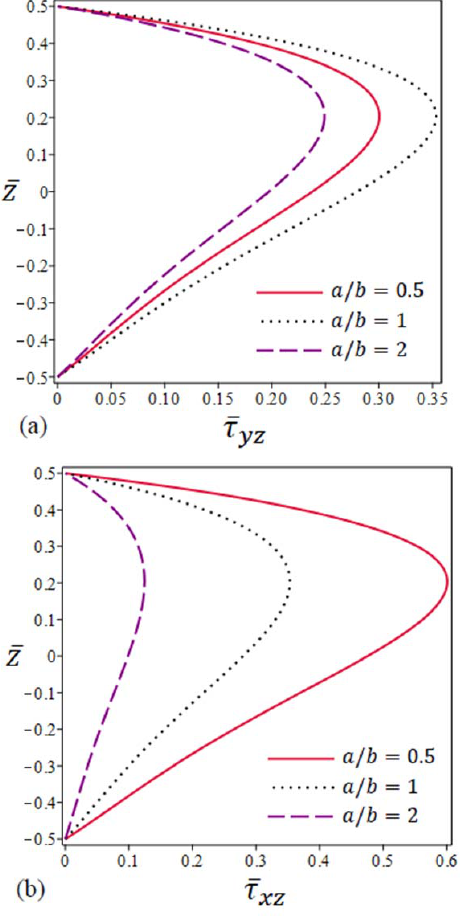
Figure 6: The transverse shear stresses across the thickness of a FG plate with k = 2 and a / h = 10 : (a) τ yz , (b) τ xz .